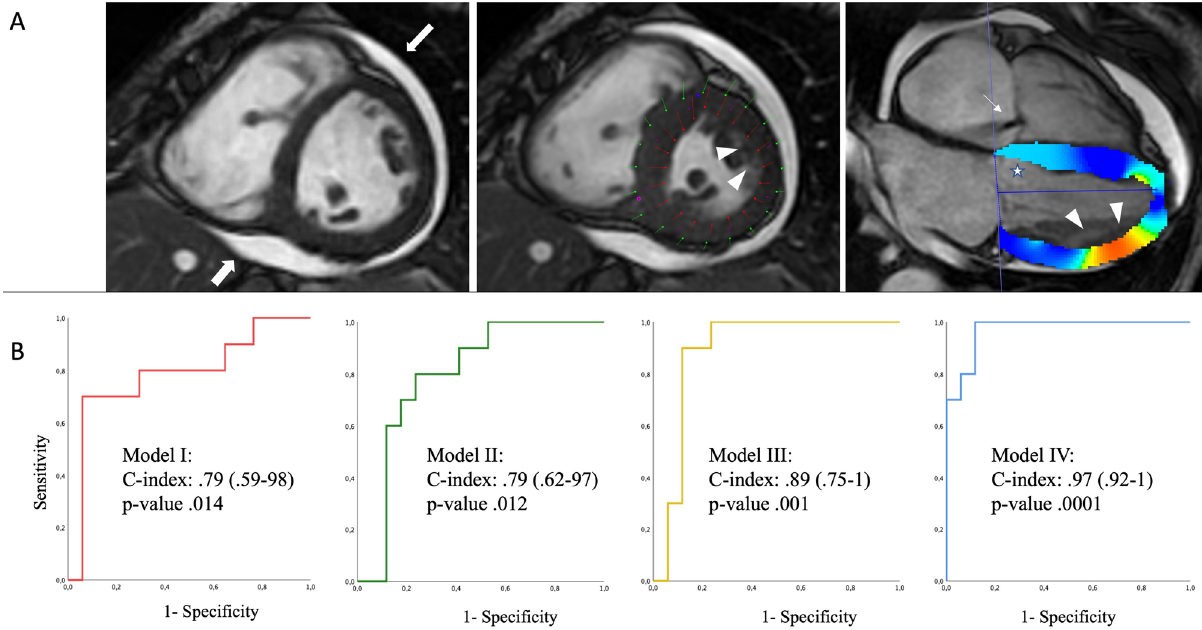
Figure 2. In panel ( A ), a SSc-HD. On the right, color map derived from CMR-TT analysis: darker blue color shows higher deformability, while lighter blue color (white star) (slight) or yellow-to-red color (moderate-to- severe) show areas of low deformability. Sequentially, SSFP cine images acquired in diastolic and systolic phases show moderate pericardial effusion (thick white arrows), with lower longitudinal deformability mainly evident in antero-lateral segment (with arrowheads). In central image, boundary points representation of CMR-TT analysis: epicardial and subendocardial deformability respectively represented in green and red lines-and-dots. Thin white arrow highlight slight tricuspid regurgitation. In ( B ) panel, ROC analysis for Model I, II, III and IV. Model I (conventional clinical score): red line. Model II (Model I + cardiac volumes): green line. Model III (Model II + pericardial involvement): yellow line. Model IV (Model III + strain values): blu line. The highest C-index is reached by the Model IV including both pericardial and strain analysis. SSc: systemic sclerosis; HD: heart disease; CMR: cardiac magnetic resonance; TT: tissue tracking; SSFP: steady-state free